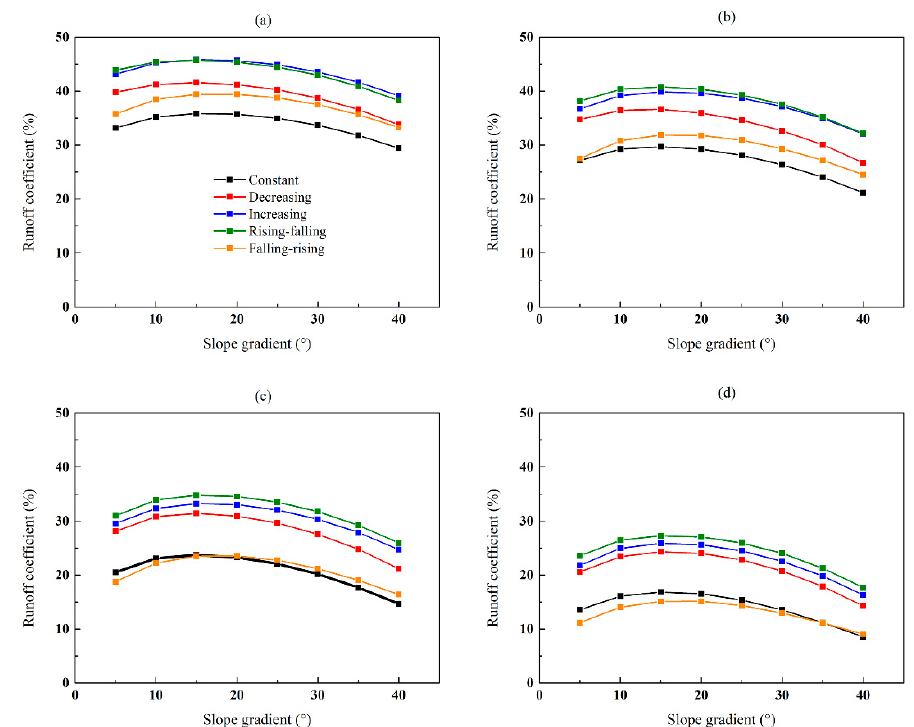
Figure 3. The runoff coefficient at different slopes with projective slope lengths of ( a ) 25 m, ( b ) 50 m, ( c ) 100 m and ( d ) 200 m.